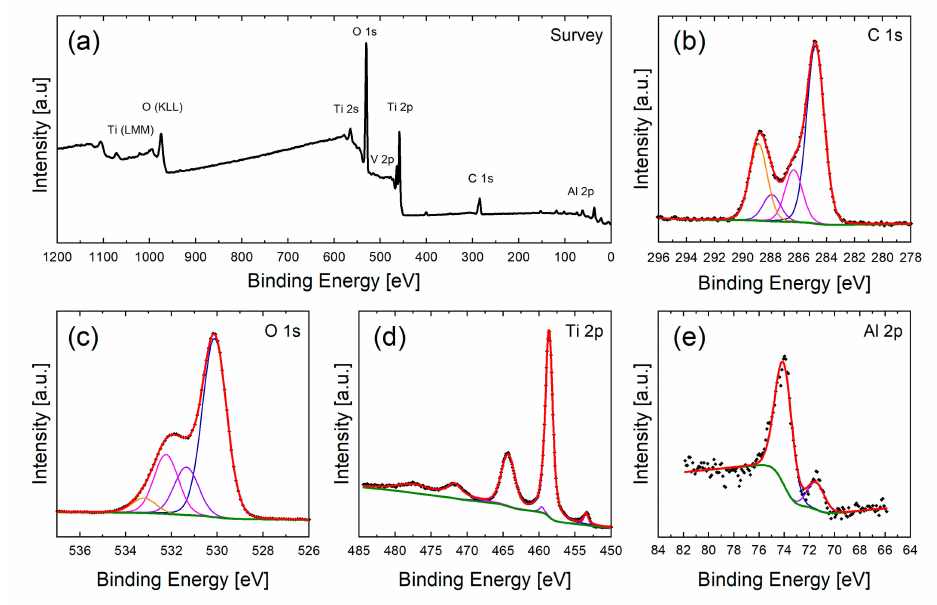
Figure 3. XP spectra of the unstructured sample without cleaning after 1d storage in air. In the survey spectra ( a ) the main components Ti, O, Al and C can be identified. The detailed high-resolution scans of these components C 1s ( b ), O 1s ( c ), Ti 2p ( d ) and Al 2p ( e ) are shown below.